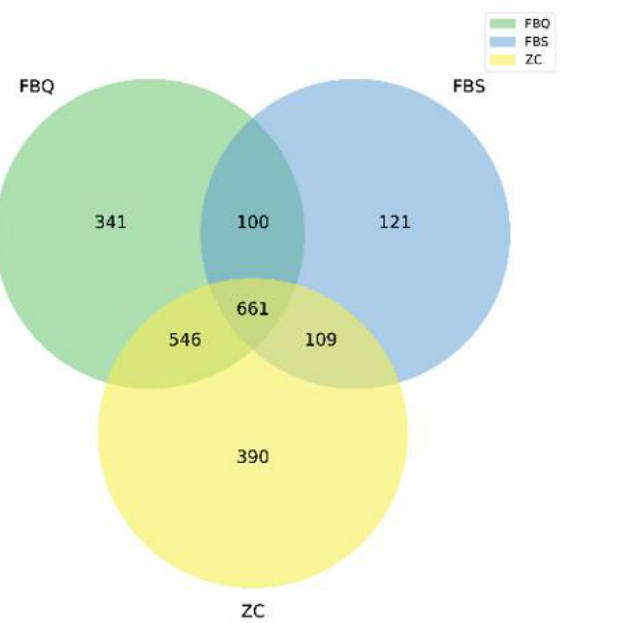
Figure 1. Venn diagram of bacterial diversity of Mianning hams. The figures in different compartments mean the numbers of bacterial specific for or common to Mianning hams of different qualities.